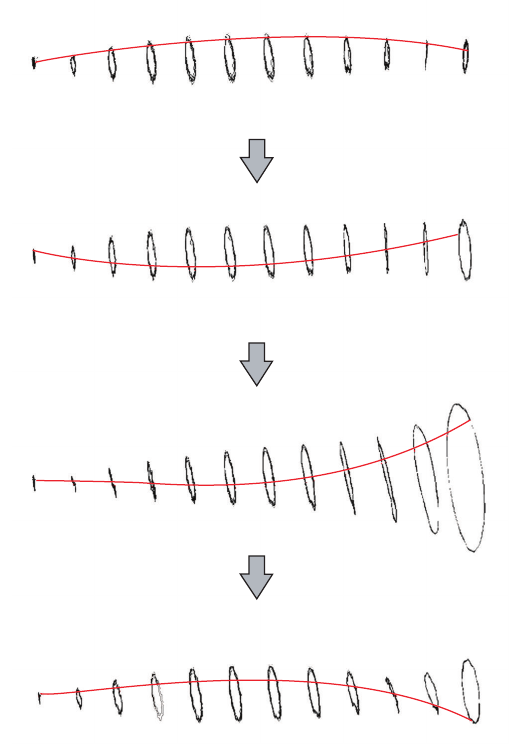
Figure 8: Orbital evolution of the flexible rotor passing through the first forward critical